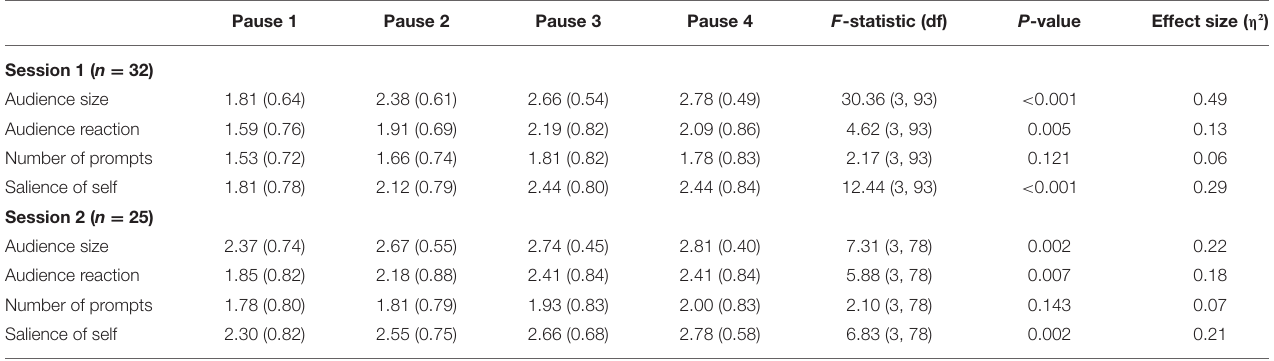
TABLE 2 | Self-guided exposure to social threat within the virtual environment †